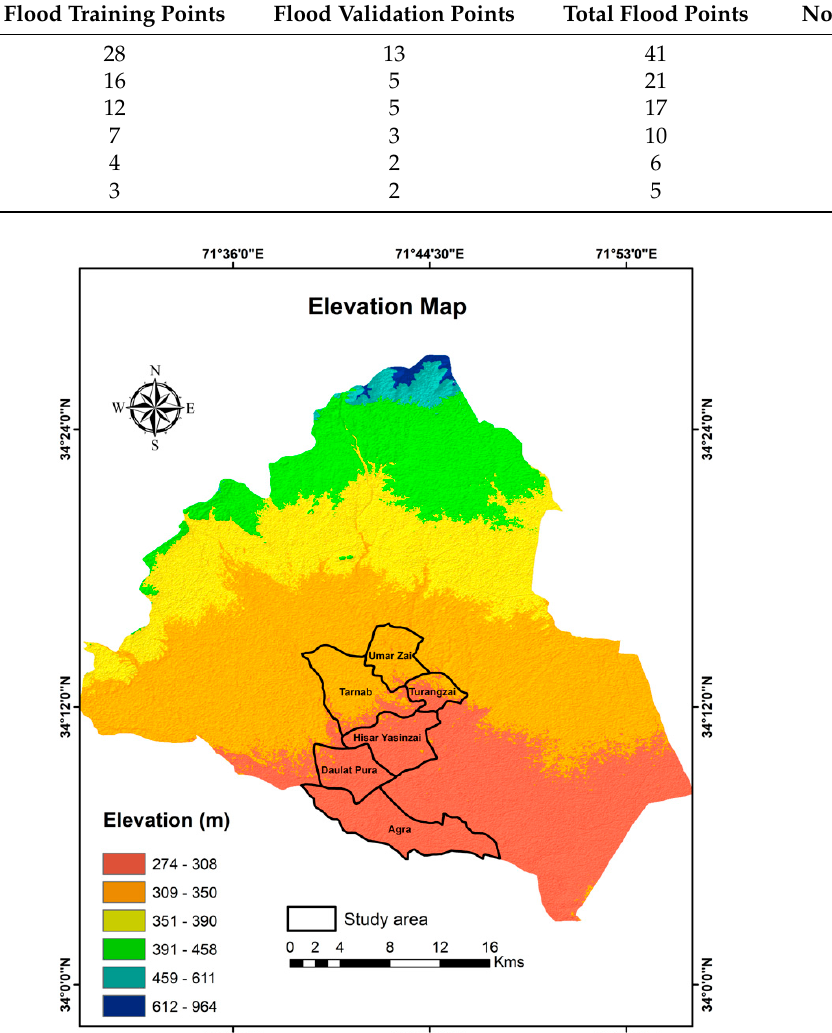
Figure 6. Elevation map of the study area.